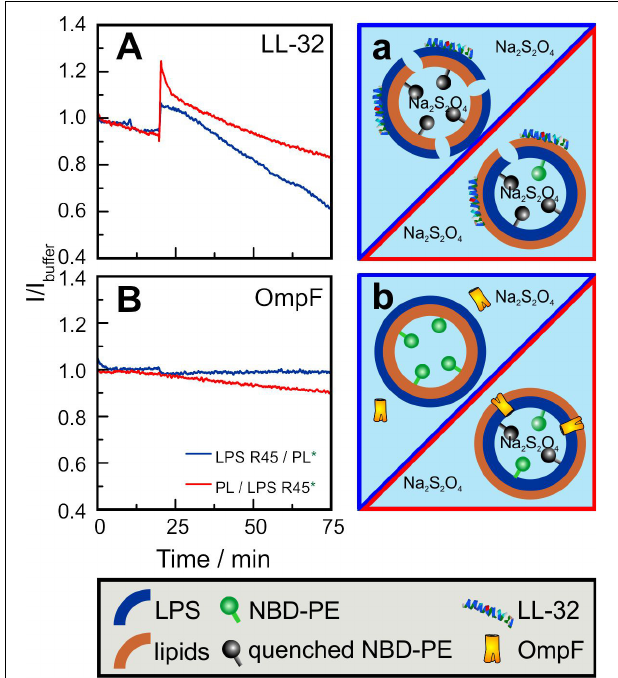
FIGURE 8 | Inner leaflet labeled asymmetric GUVs enable the determination of orientation-sensitive quencher-uptake dynamics through (A,a) LL-32 induced lesions and through (B,b) bacterial porin OmpF. GUVs prepared by the phase transfer method were composed of LPS R45 on the outer leaflet and the PL mixture (PE:PG:CL; 81:17:2; w/w/w) on the inner leaflet ( A: blue curves; a :blue framing) and vice versa ( A: red curves; a: red framing). After 10 min, Na 2 S 2 O 4 was added to a final concentration of 10 mM. (A) After 20 min, LL-32 was added to a final concentration of 30 µ M. After a first intensity increase because of peptide insertion a decrease because of the quenching of the inner leaflet marker NBD-PE (2%) can be seen. (B) After 20 min OmpF was added to a final concentration of 5 µ g/ml. Influx of the quencher Na 2 S 2 O 4 only occurs if the PL mixture is faced outward and directly exposed to the protein. Experiments were performed in 100 mM KCl, 5 mM MgCl 2 , and 5 mM HEPES at pH 7.0 and at T = 37 ◦